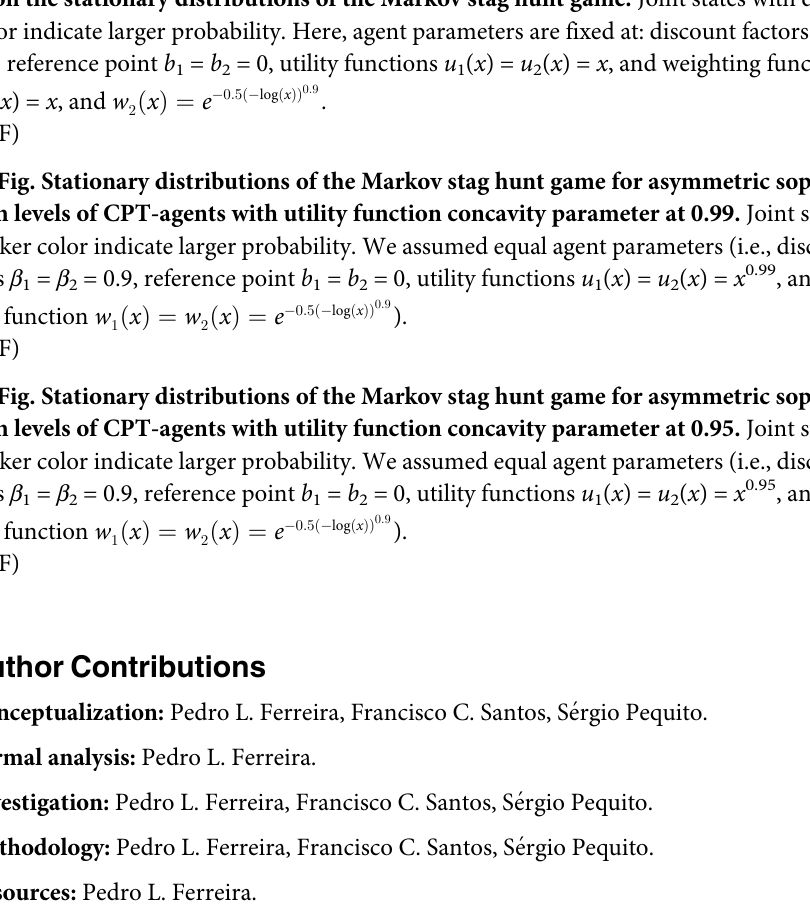
S3 Fig. Role of discount factor β on the stationary distributions of the resulting Markov chains obtained by conditioning the Markov game to increasingly sophisticated policies ( k = 1, 2, 3, 4) for EUT-agents and CPT-agents. Joint states with darker color indicate larger probability. We assumed reference points b = b = 0, utility function u ( x ) = x and weighting 1 2 function w ( x ) = x for EUT and w ð x Þ ¼ e (cid:0) 0 : 5 ð(cid:0) log ð x ÞÞ 0 : 9 for CPT. (Left) Stationary distribution for EUT- and CPT-agents using discount factor β = 0.85. (Right) Stationary distribution for EUT- and CPT-agents using discount factor β = 0.95. (TIF) S4 Fig. Role of sophistication level of two EUT-agents on the stationary distributions of the Markov stag hunt game. Joint states with darker color indicate larger probability. We assumed equal agent parameters: discount factors β = β = 0.9, reference point b = b = 0, 1 2 1 2 utility functions u ( x ) = u ( x ) = x , and weighting function w ( x ) = w ( x ) = x ). 1 2 1 2 (TIF) S5 Fig. Role of sophistication level of one EUT-agent (agent 1) and one CPT-agent (agent 2) on the stationary distributions of the Markov stag hunt game. Joint states with darker color indicate larger probability. Here, agent parameters are fixed at: discount factors β = β = 1 2 0.9, reference point b = b = 0, utility functions u ( x ) = u ( x ) = x , and weighting functions 1 2 1 2 ð x Þ ¼ e (cid:0) 0 : 5 ð(cid:0) log ð x ÞÞ 0 : 9 . w 1 ( x ) = x , and w 2 S6 Fig. Stationary distributions of the Markov stag hunt game for asymmetric sophistica- tion levels of CPT-agents with utility function concavity parameter at 0.99. Joint states with darker color indicate larger probability. We assumed equal agent parameters (i.e., discount fac- tors β = β = 0.9, reference point b = b = 0, utility functions u ( x ) = u ( x ) = x 0.99 , and weight- 1 2 1 2 1 2 ing function w ð x Þ ¼ w ð x Þ ¼ e (cid:0) 0 : 5 ð(cid:0) log ð x ÞÞ 0 : 9 ). 1 2 S7 Fig. Stationary distributions of the Markov stag hunt game for asymmetric sophistica- tion levels of CPT-agents with utility function concavity parameter at 0.95. Joint states with darker color indicate larger probability. We assumed equal agent parameters (i.e., discount fac- tors β = β = 0.9, reference point b = b = 0, utility functions u ( x ) = u ( x ) = x 0.95 , and weight- 1 2 1 2 1 2 ing function w ð x Þ ¼ w ð x Þ ¼ e (cid:0) 0 : 5 ð(cid:0) log ð x ÞÞ 0 : 9 1 2